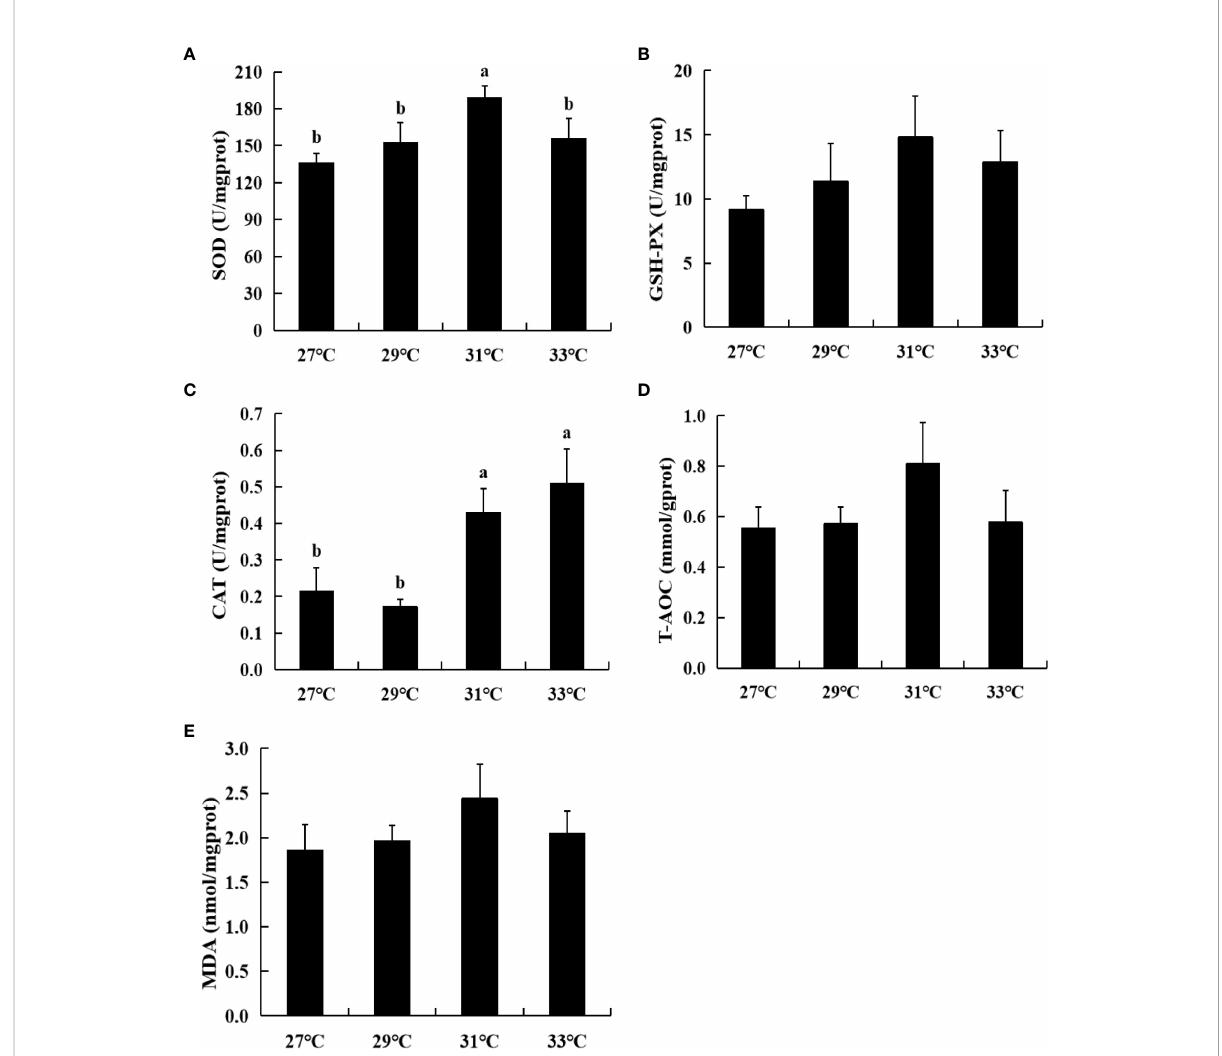
FIGURE 6 Embryo antioxidant index of swimming crab at four water temperatures. (A) Superoxide dismutase (SOD); (B) Glutathione peroxidase (GSH-Px); (C) Catalase (CAT); (D) Total antioxidant capacity (T-AOC); (E) Malondialdehyde (MDA). Different lowercase letters above the fi gure column indicate that there are signi fi cant differences between different temperature groups ( P<